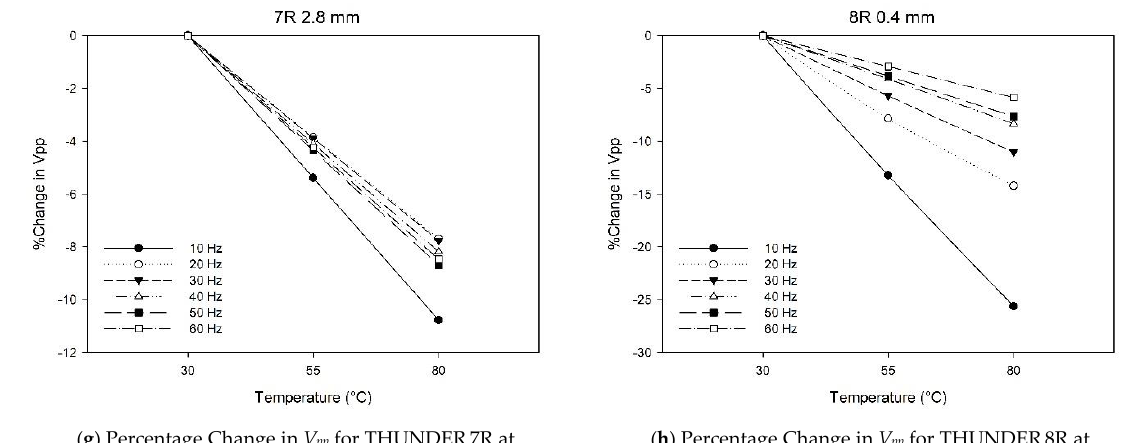
Figure 10. Percentage Change in peak-to-peak voltage of THUNDER 6R, 7R and 8R versus temperature at various frequencies and pushing displacements. ( a ) THUNDER 6R–displacement 0.4 mm. ( b ) THUNDER 6R–displacement 1.0 mm. ( c ). THUNDER 6R–displacement 1.6 mm. ( d ) THUNDER 7R–displacement 0.4 mm. ( e ) THUNDER 7R–displacement 1.0 mm. ( f ) THUNDER 7R–displacement 1.6 mm. ( g ) THUNDER 7R–displacement 2.8 mm. ( h ) THUNDER 8R–displacement 0.4